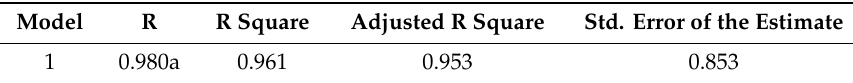
Table 3. Model summary.